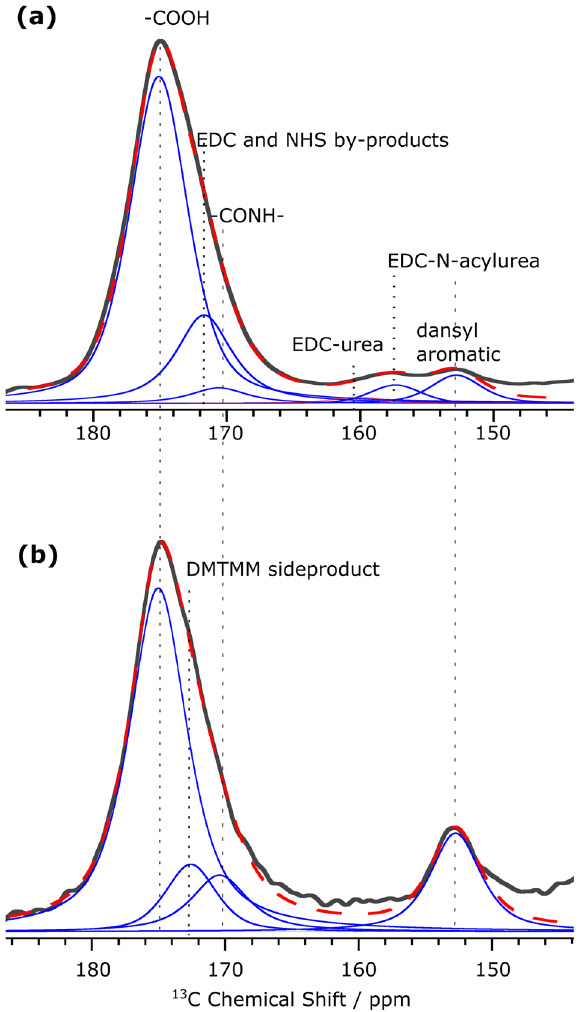
Fig. 4 DNP-enhanced 13C NMR of surface-functionalized CNF. Signal deconvolution of the region between 145 and 185 ppm in 1 3 C DNP- enhanced CPMAS spectra (in black) of a CNF-dansyl/EDC-NHS and b CNF-dansyl/DMTMM. The deconvolution components are shown in blue and their sum in red (dashed line). Assignment is indicated in the fi gure. DMTMM side product refers here to DMT-OH.